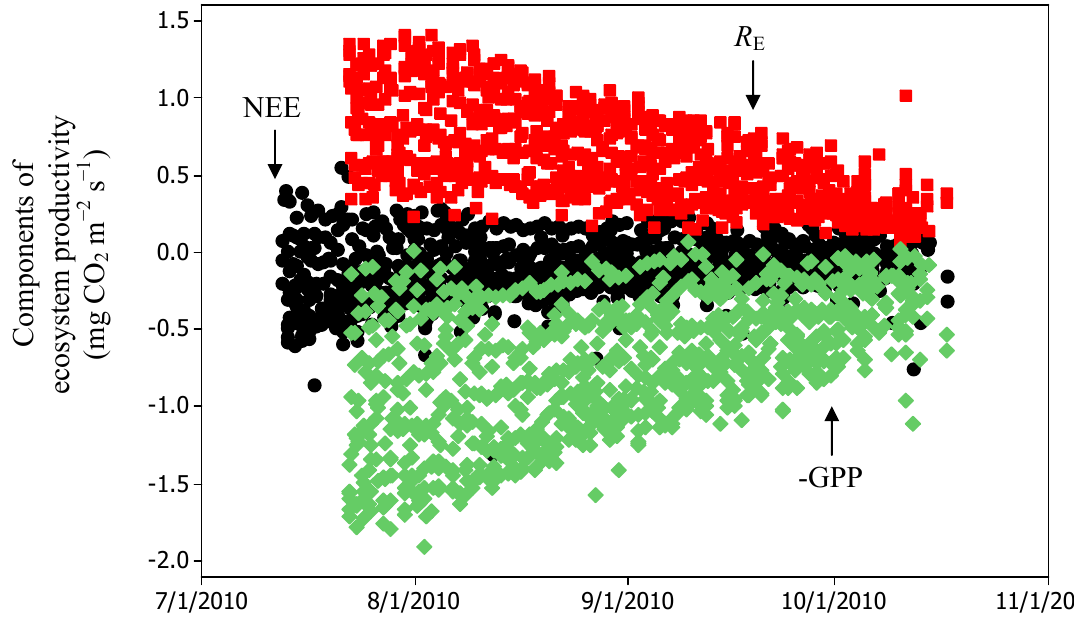
Figure 8. Estimation of GPP and daytime R on Equation (6) ( n = 1021 for NEE; and n = 896 for GPP and R